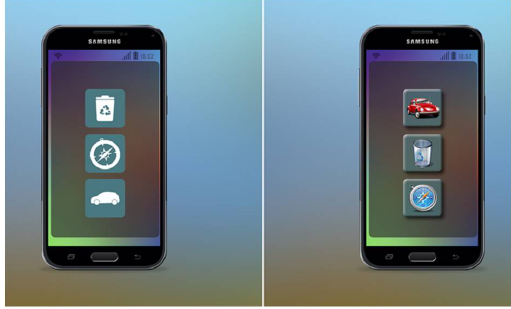
Figure 2. Screens displayed to users in Step 2 (recall the icon).